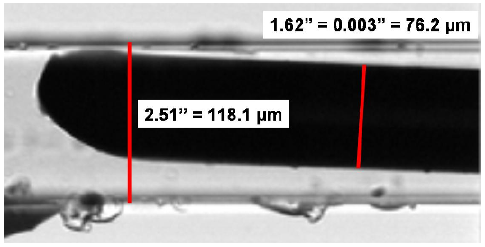
Figure 4. Branch inlet channel width